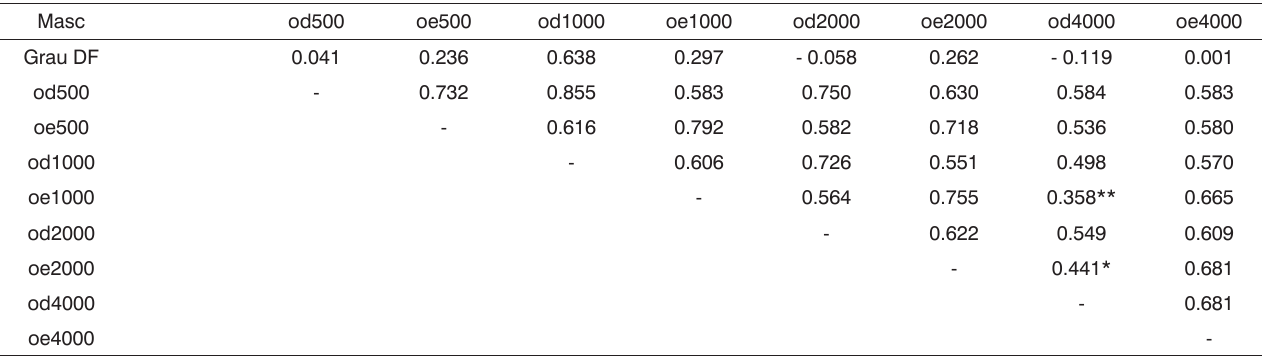
Tabela 5. Resultados obtidos no cruzamento entre as frequências do reflexo acústico contralateral e na relação com a gravidade do desvio fonológico no gênero